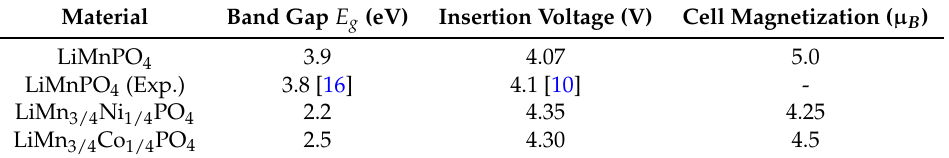
Table 2. Properties of LiMnPO 4 and derived doped structures: band gap E g , lithium insertion potential, and cell magnetization per unit formula. Experimental band gap for LiMnPO 4 was taken form García-Moreno et al. [54] and insertion potential form Li et al. [10]. The simulations agree very well with the experimental measurements. No experimental data are available for the doped